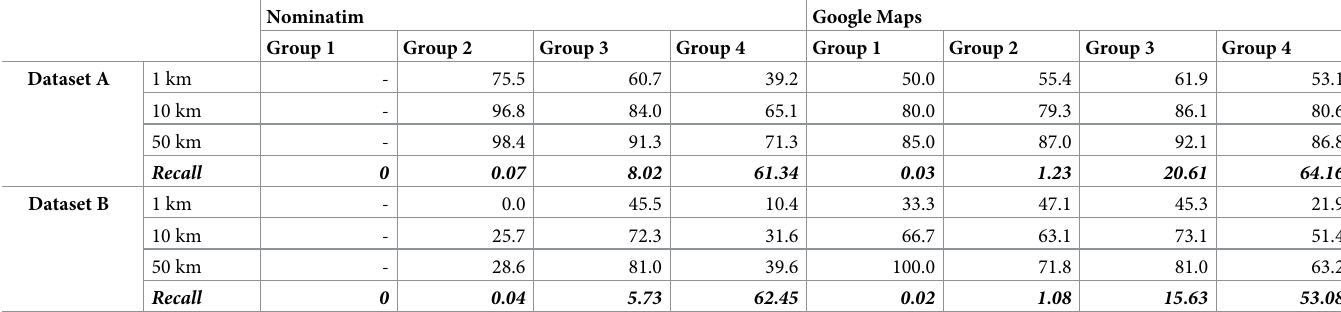
Table 7. Precision and recall values per group for Datasets A and B derived from precision values returned by Nominatim and Google